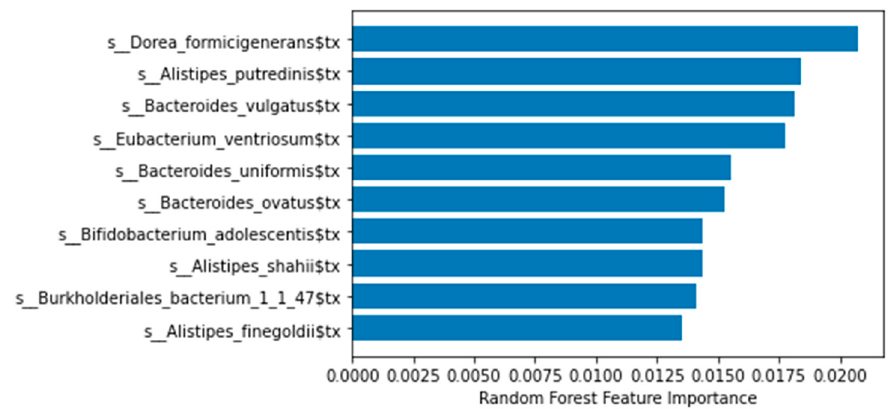
Figure 5. Feature importance (metagenomic data) with a RF. Only the first ten features are shown for illustrative purposes. Generated with a Python script.